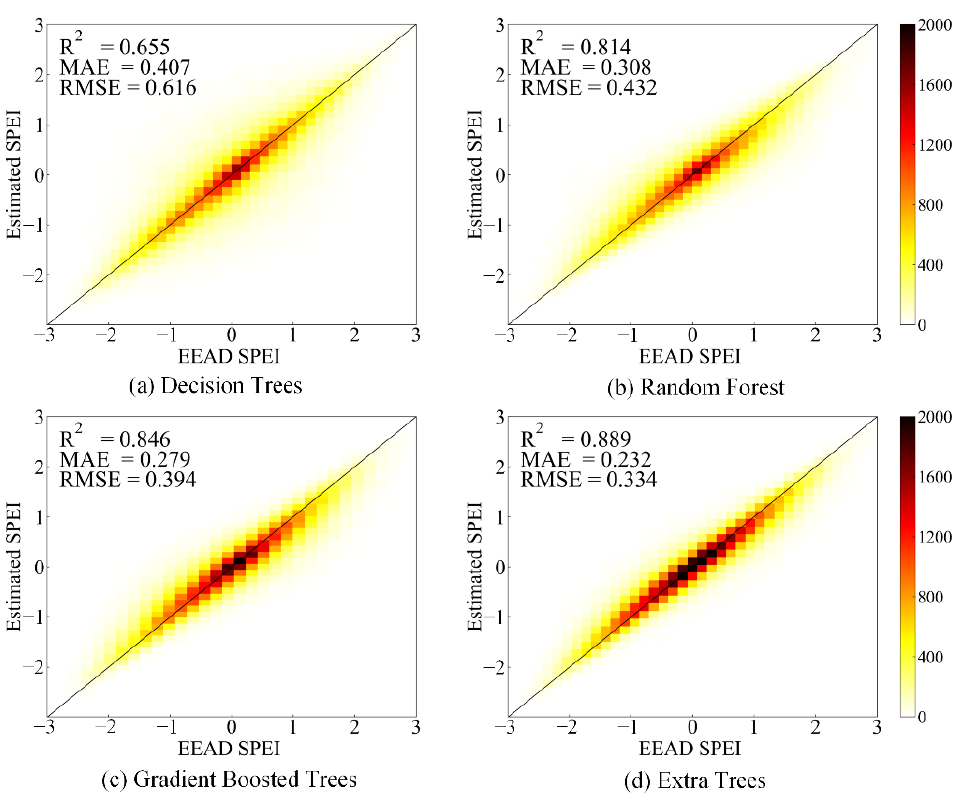
Figure 3. Density scatter plot between EEAD and predicted SPEI based on ( a ) DT, ( b ) RF, ( c ) GBRT, and ( d ) ET. Results are from cross-validation.